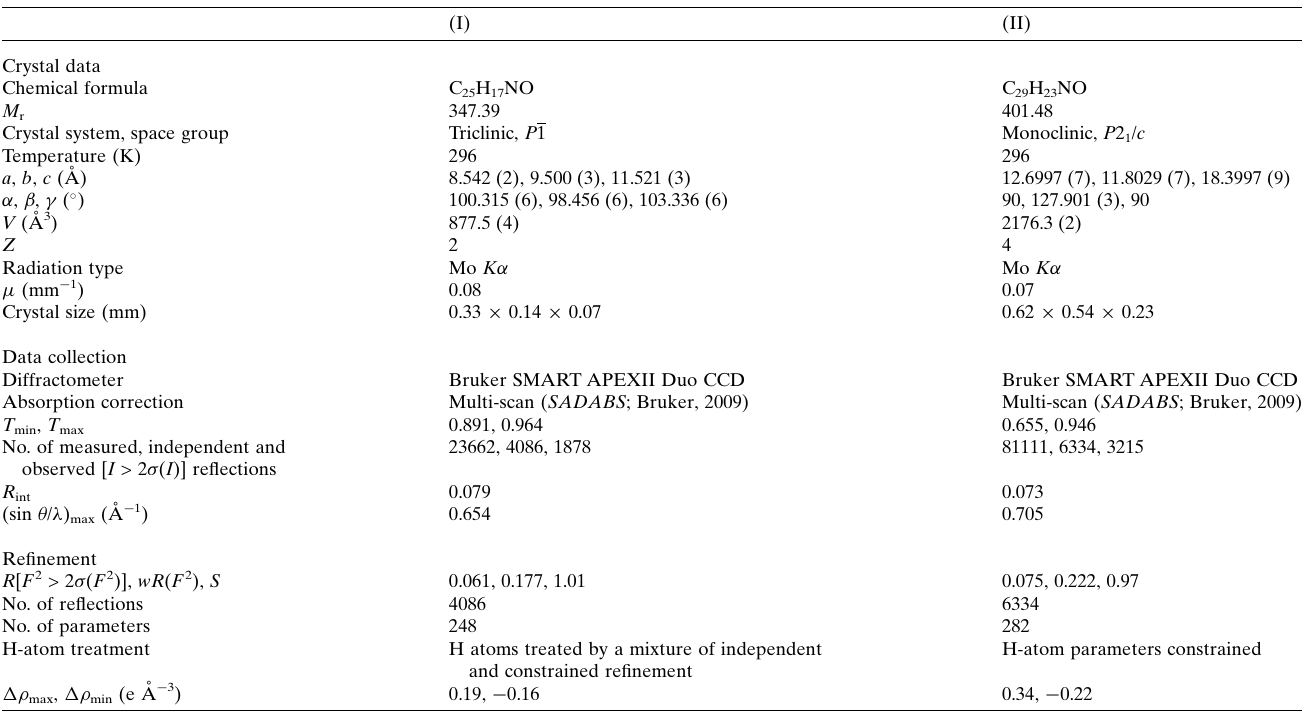
Table 3 Experimental details.